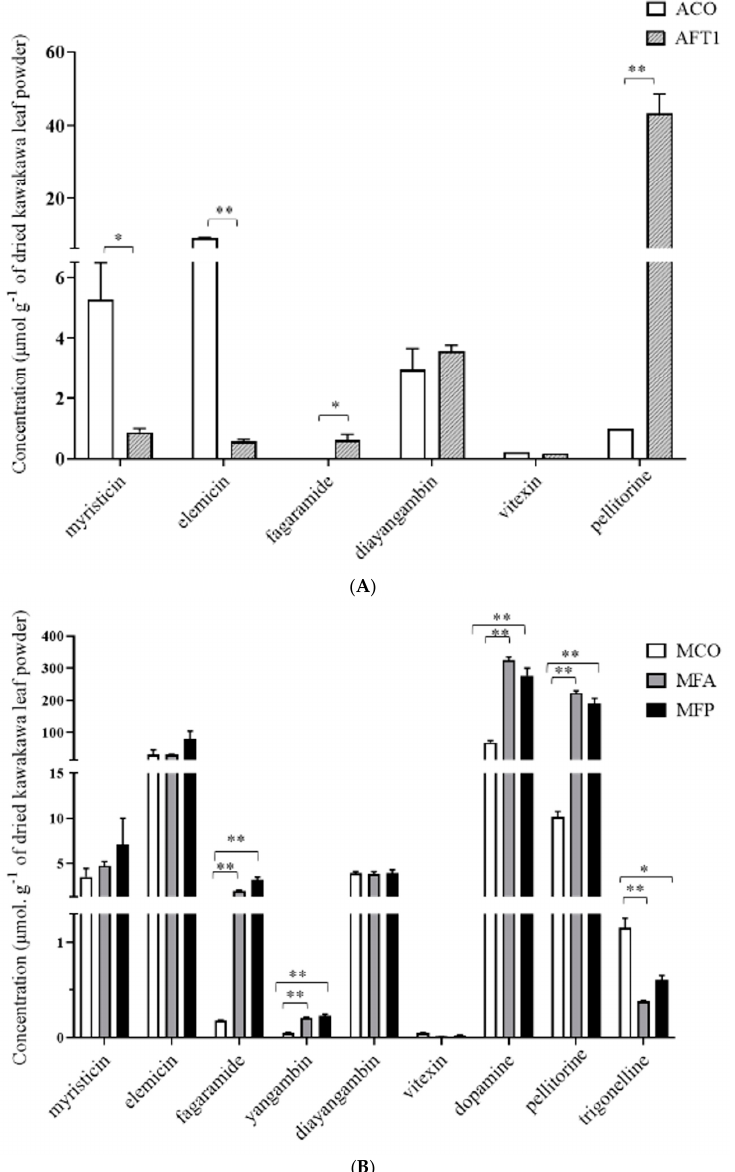
Figure 4. Absolute quantification of kawakawa phytochemicals obtained from ( A ) aqueous extraction of Ō KU leaf powder (ACO) and fresh leaves from the Nelson region (AFT1), and ( B ) methanol extraction of Ō KU leaf powder (MCO) and fresh leaf powders collected from Arapaoa Island (MFA) and P¯ohara (MFP). Values are mean ± SD ( n = 3). * indicates p < 0.01, ** indicates p <